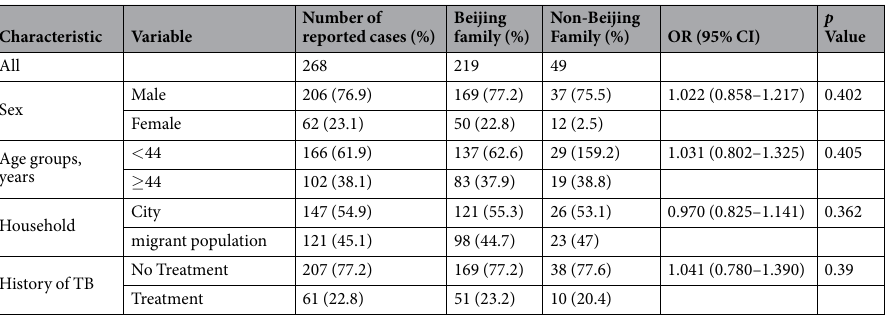
Table 1. The background information of 268 patients. P value indicates whether there is a significant difference between Beijing family and non-Beijing family in sex, age, household, and history of TB. ( P < 0.05 represents a statistically significant